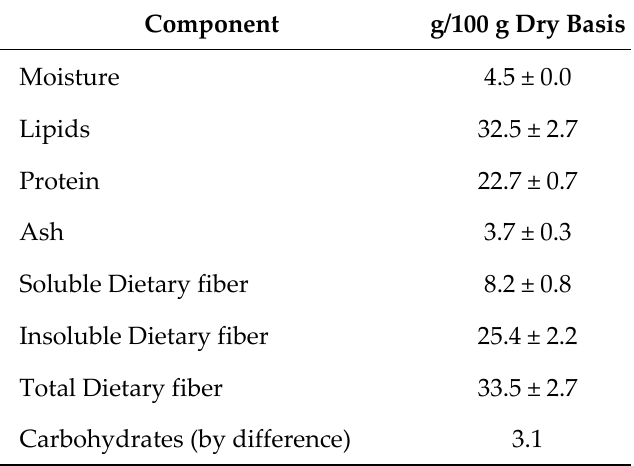
Table 1. Proximate composition and dietary fiber of chia seed.